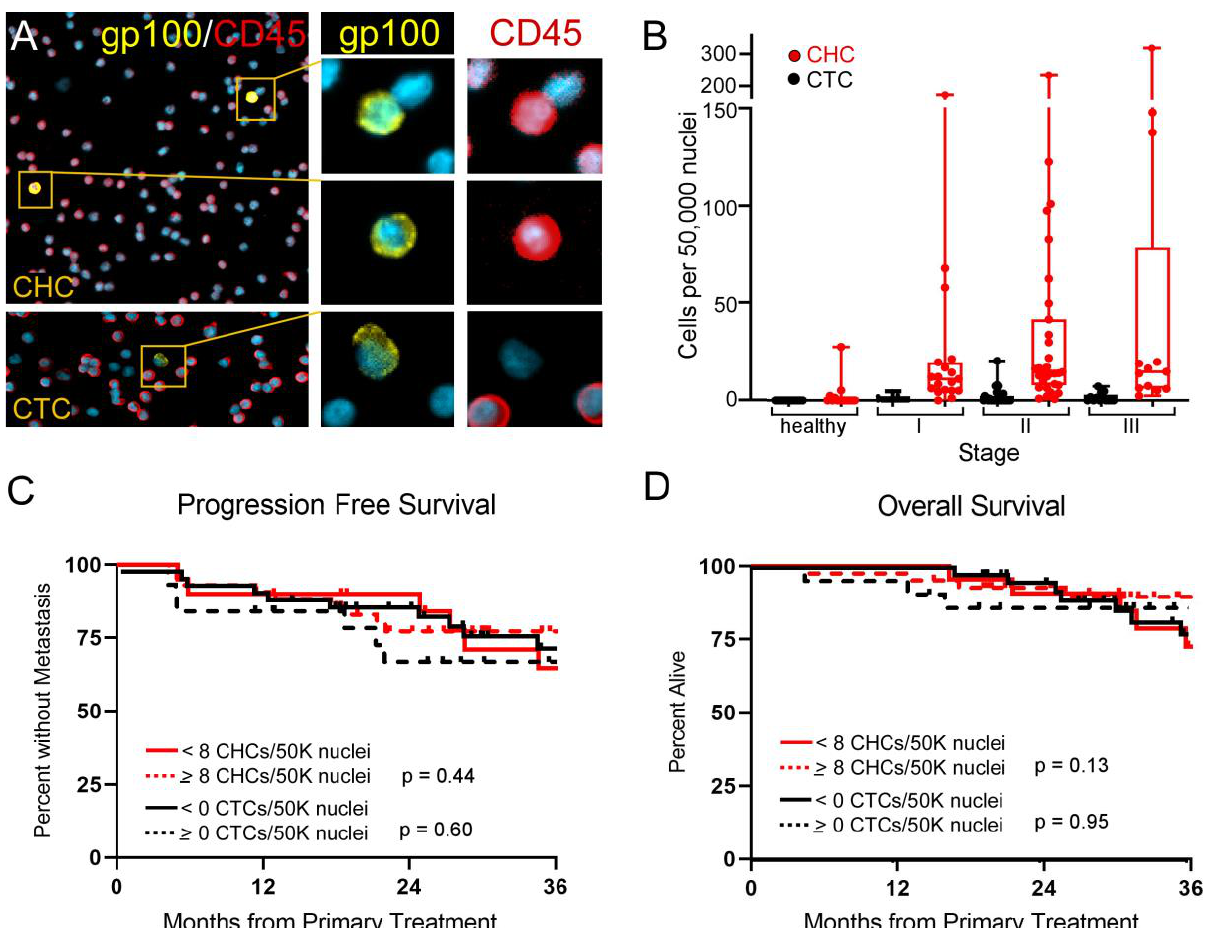
Figure 1. Detected gp100 + circulating hybrid cells (CHCs) do not correlate with uveal melanoma stage or predict survival outcomes. ( A ) Peripheral blood mononuclear cells stained with antibodies to gp100 and CD45 facilitate identification of CHCs and circulating tumor cells (CTCs). Higher magnification of boxed regions with individual antibody staining shown on right. ( B ) Enumerated CHCs and CTCs in healthy subjects and patients across AJCC disease stage. ( C ) High levels of CHCs or CTCs do not correlate with progression-free survival or ( D ) overall